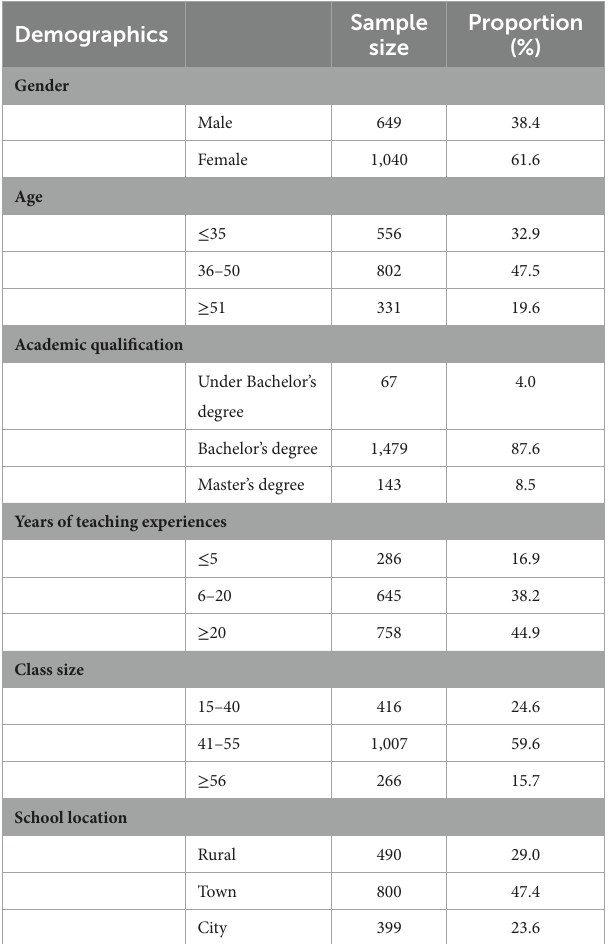
TABLE 2 Demographic characteristics of the